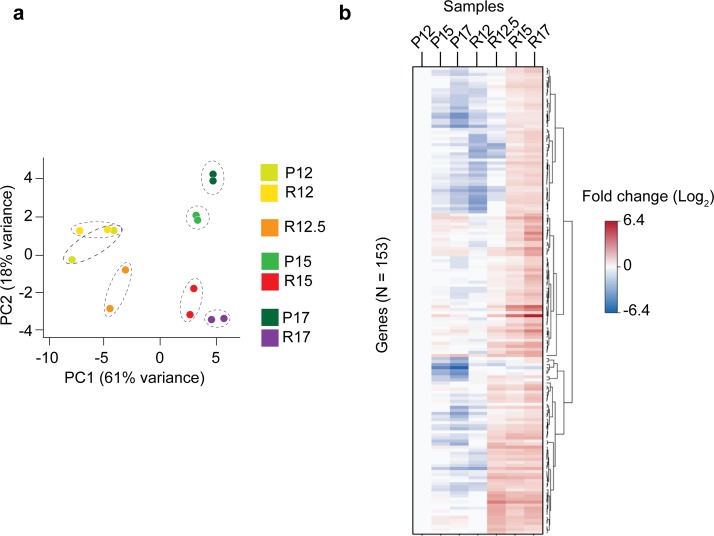
Angiogenic associated genes.(a) Principal component analysis using 500 genes with the highest variance in expression. PC1 is stage dependent, and PC2 is condition dependent (OIR or normal retina development); these components explain 61% and 18% of variance, respectively; filtered by genes with > 500 reads on all samples. (b) Heatmap and dendrogram illustrating the expression profile of the 153 differentially expressed genes across all retina samples (fold-change ≥ 2).